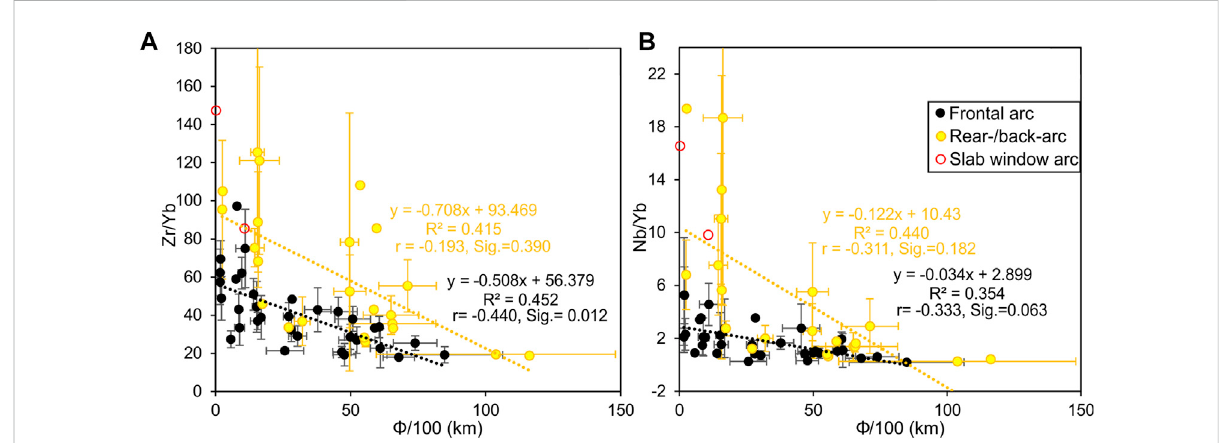
FIGURE 4 Bivariant diagrams of slab thermal parameter Φ /100 ( Φ =convergence velocity × slab age × the sine of slab dip) vs. incompatible trace element ratio Zr/Yb (A) and Nb/Yb (B) of frontal arc and rear-/back-arc rocks. The partial correlation coef fi cient r is calculated when the crustal thickness is taken as the control variable, with 2-tailed signi fi cance.